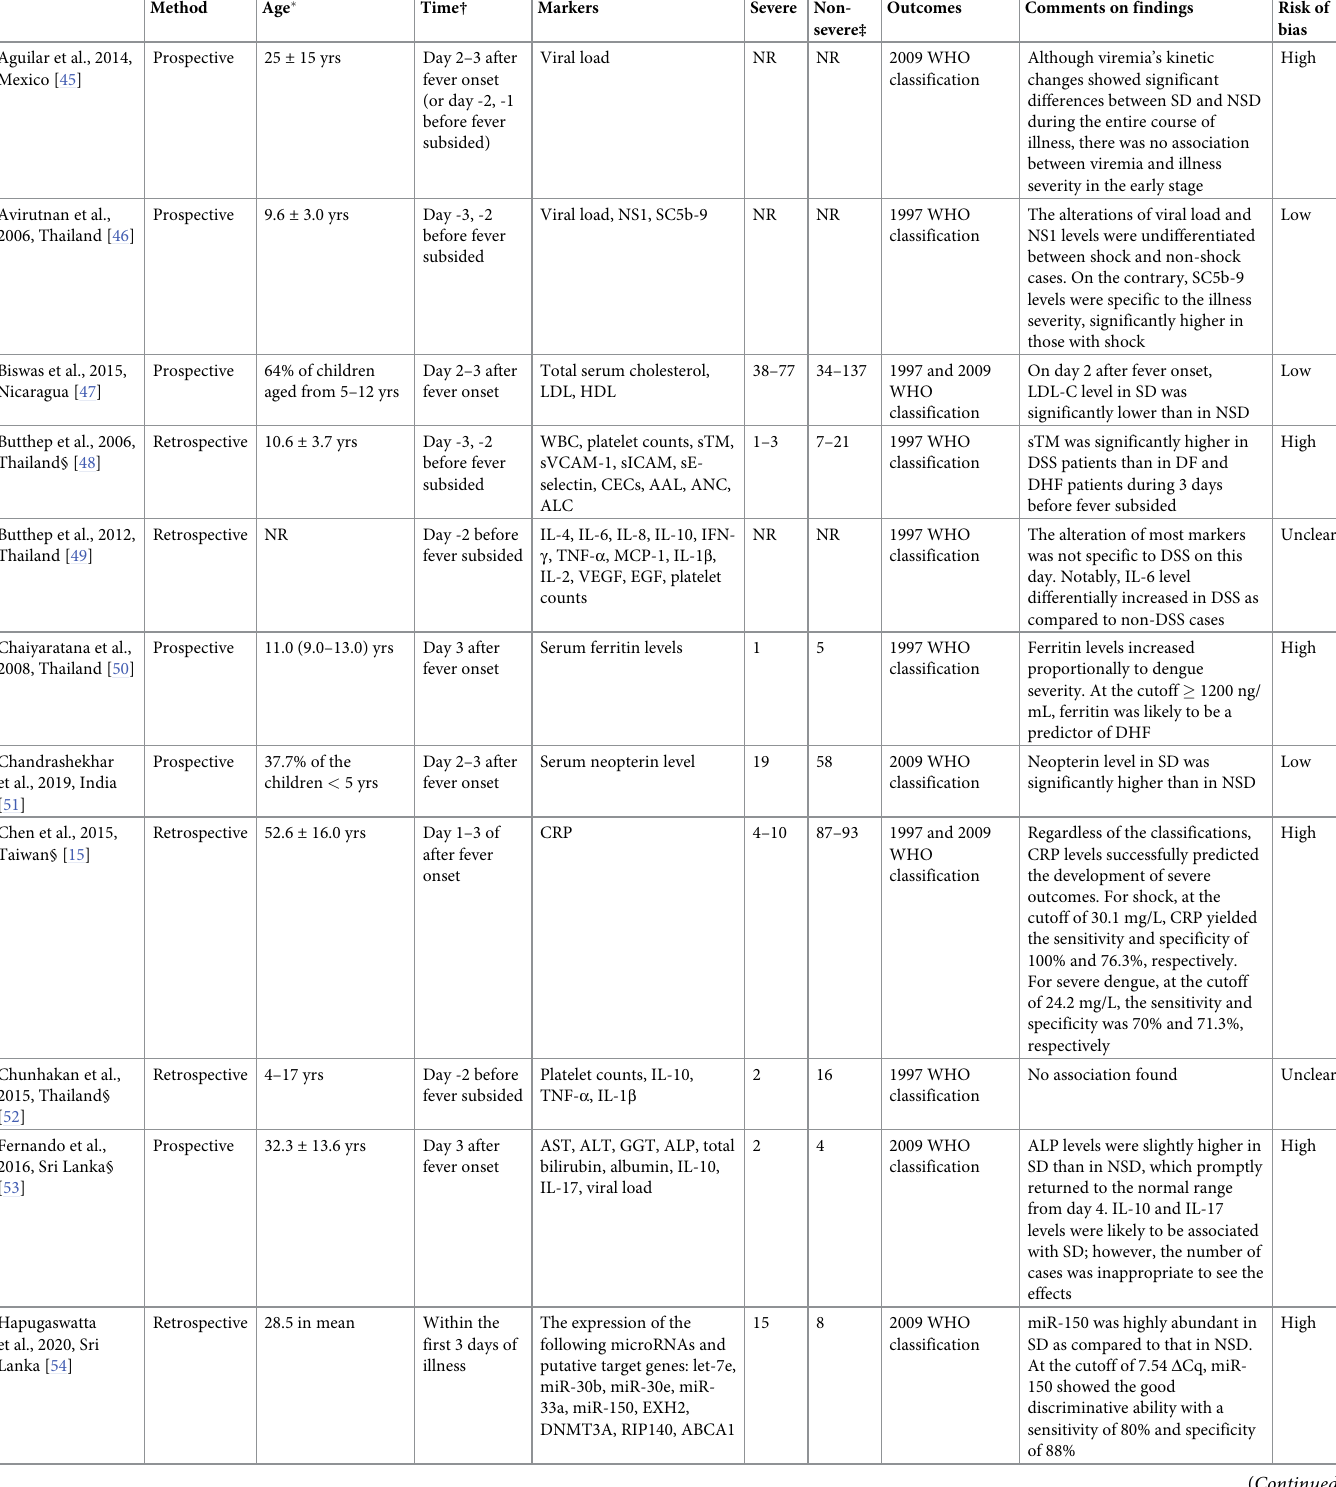
Table 1. Characteristics of included